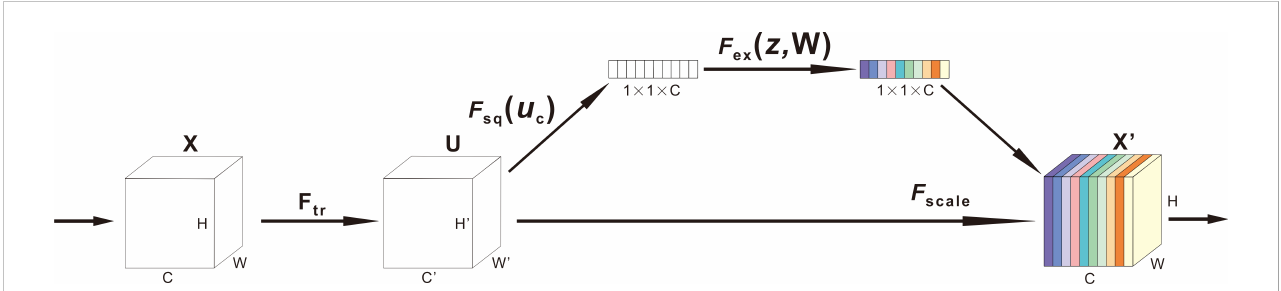
FIGURE 7 The structure of